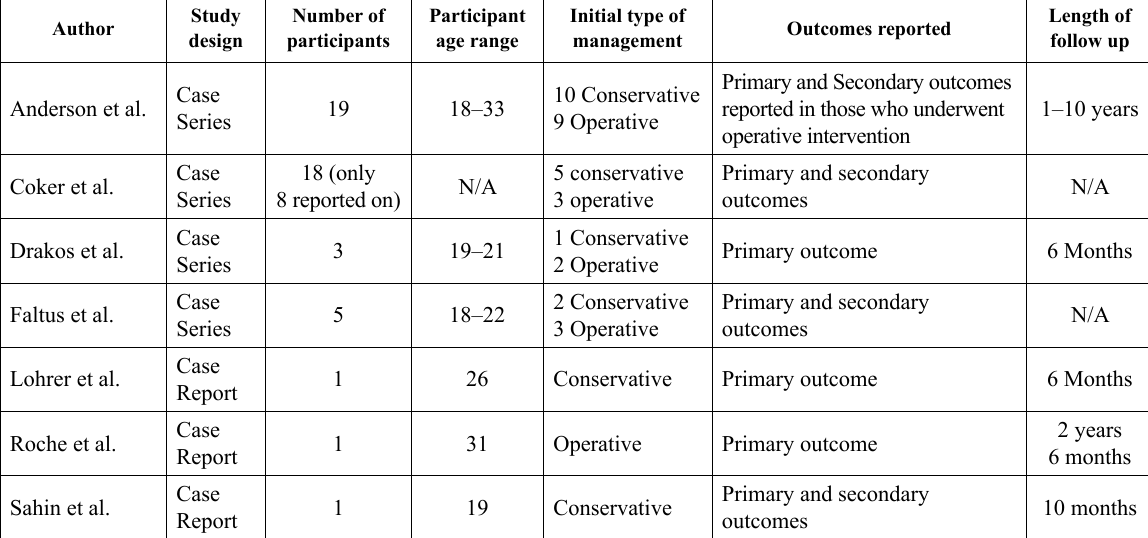
Table 2. Summary table of included studies evaluating the management of turf toe